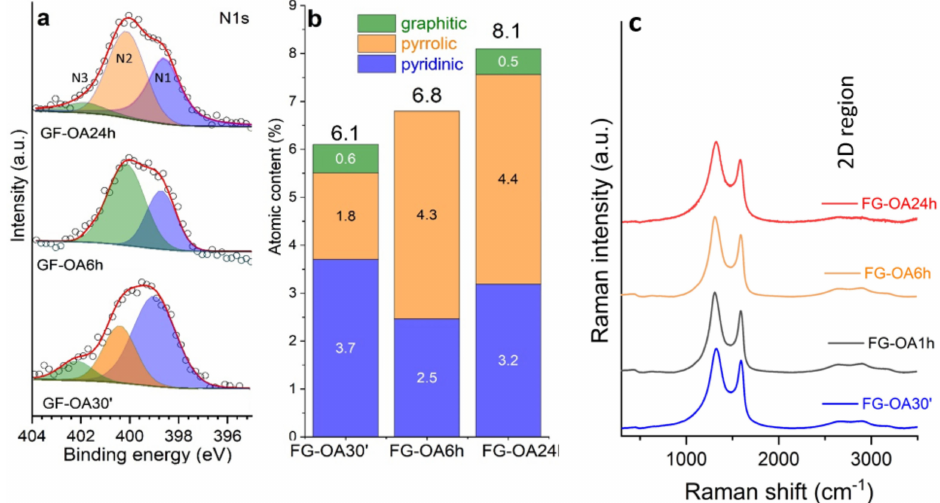
Figure 3. ( a ) High-resolution X-ray photoelectron spectroscopy of the N1s regions showing the deconvoluted nitrogen components in pyridinic (N1), pyrrolic (N2) and graphitic (N3) configurations. ( b )Totalatomicnitrogencontentinthesamplesandatomiccontentsofthedi ff erentnitrogencomponents. ( c ) Raman